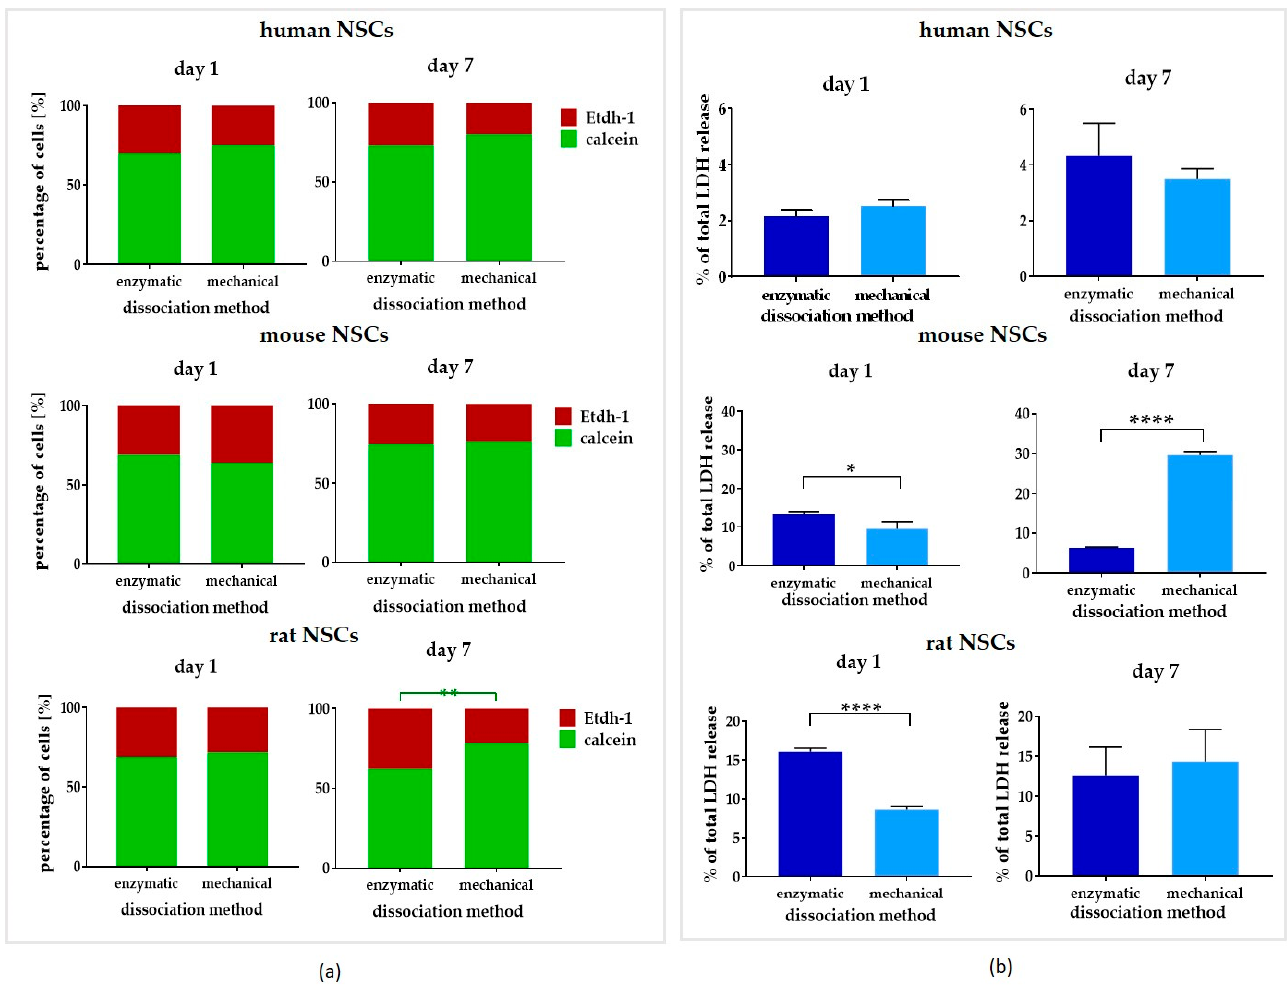
Figure 9. The influence of dissociation methods—enzymatic and mechanical—( a ) on NSCs’ calcein+ and Etdh-1+ cells’ presence on Day 1 and Day 7 of culture, and ( b ) on NSCs’ LDH release on culture Days 1 and 7. Cell culture conditions: 5% O 2 , 5% CO 2 , 37 °C, N = 3. The results of all presented experiments are expressed as mean values of three experiments ± SEM. The differences were considered statistically significant when the p -value < 0.05. Statistical significance level: * for 0.01 < p < 0.05, ** for 0.001 < p < 0.01, and **** for p < 0.0001.